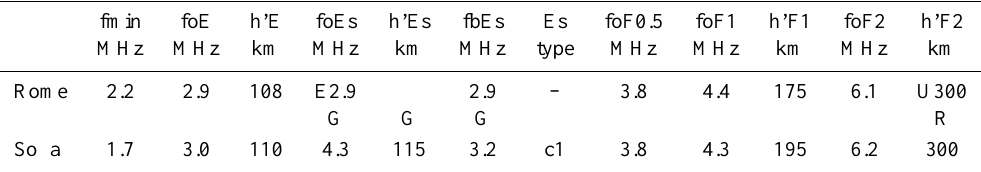
Table 1. Ionospheric parameters on 12 October 1997 at 11:00UT ∗ .